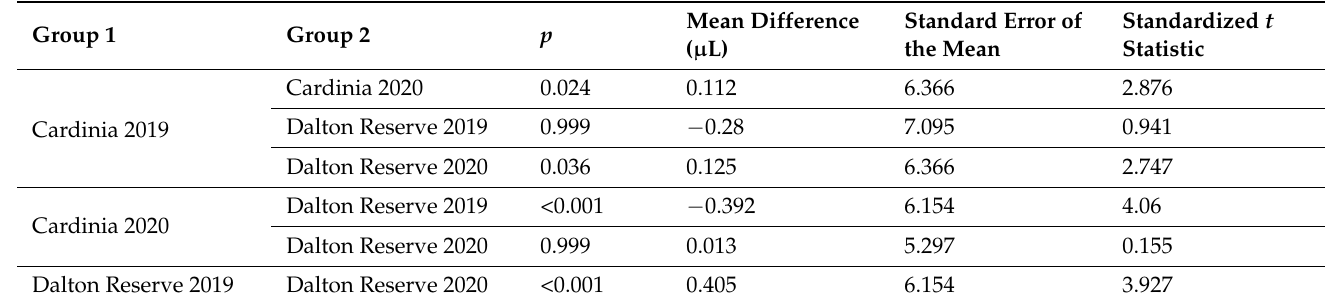
Table A7. Summary of Kruskal-Wallis pairwise comparison testing for differences in the mean volume of honeydew produced per nymph ( µ L), between site and generation groups.